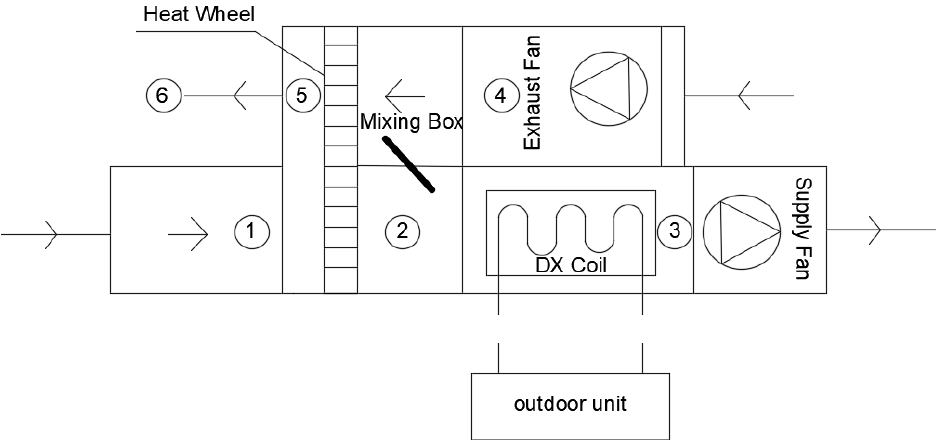
Figure 2. The schematic arrangement of components of AHU with the heat wheel. Table 1. Specification and technical data for AHU and energy